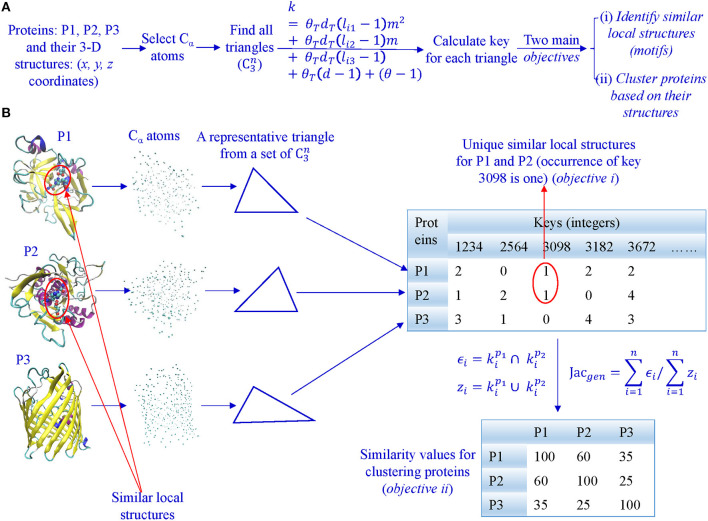
The overview of our TSR-based method for protein 3-D structural comparison at global and local levels. (A) It shows the steps involved in converting 3-D structures to keys, and objectives of our work; (B) All Cα atoms were selected from each of the representative 3-D structures, and lengths and angles of all possible triangles (C3n) were calculated. Each triangle is converted to an integer (a key) based on its lengths, angles, and amino acids. Consequently, each protein 3-D structure is represented by a vector of integers with their frequencies. A similarity matrix is calculated for clustering proteins, and identical keys with low frequencies in a certain class are found to be the candidates for motifs.